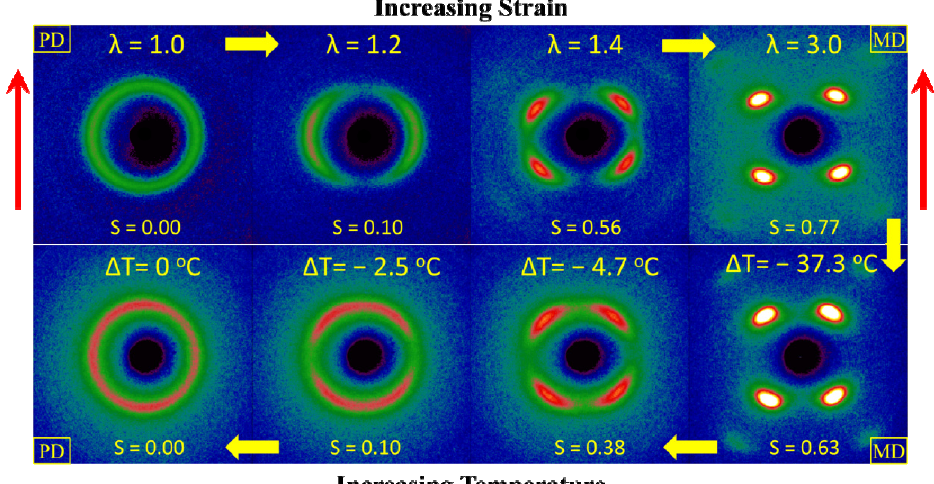
Figure 16. Small angle XRD patterns acquired during stretching (top row) and thermal recovery (bottom row) of LCE2 (LCE1 also shows similar behavior). The red arrows show the direction of stretching. The small angle peaks get increasingly close to each other (perpendicular to the stretch direction) as the temperature rises before they form a ring again. Here, PD and MD imply polydomain and monodomain,